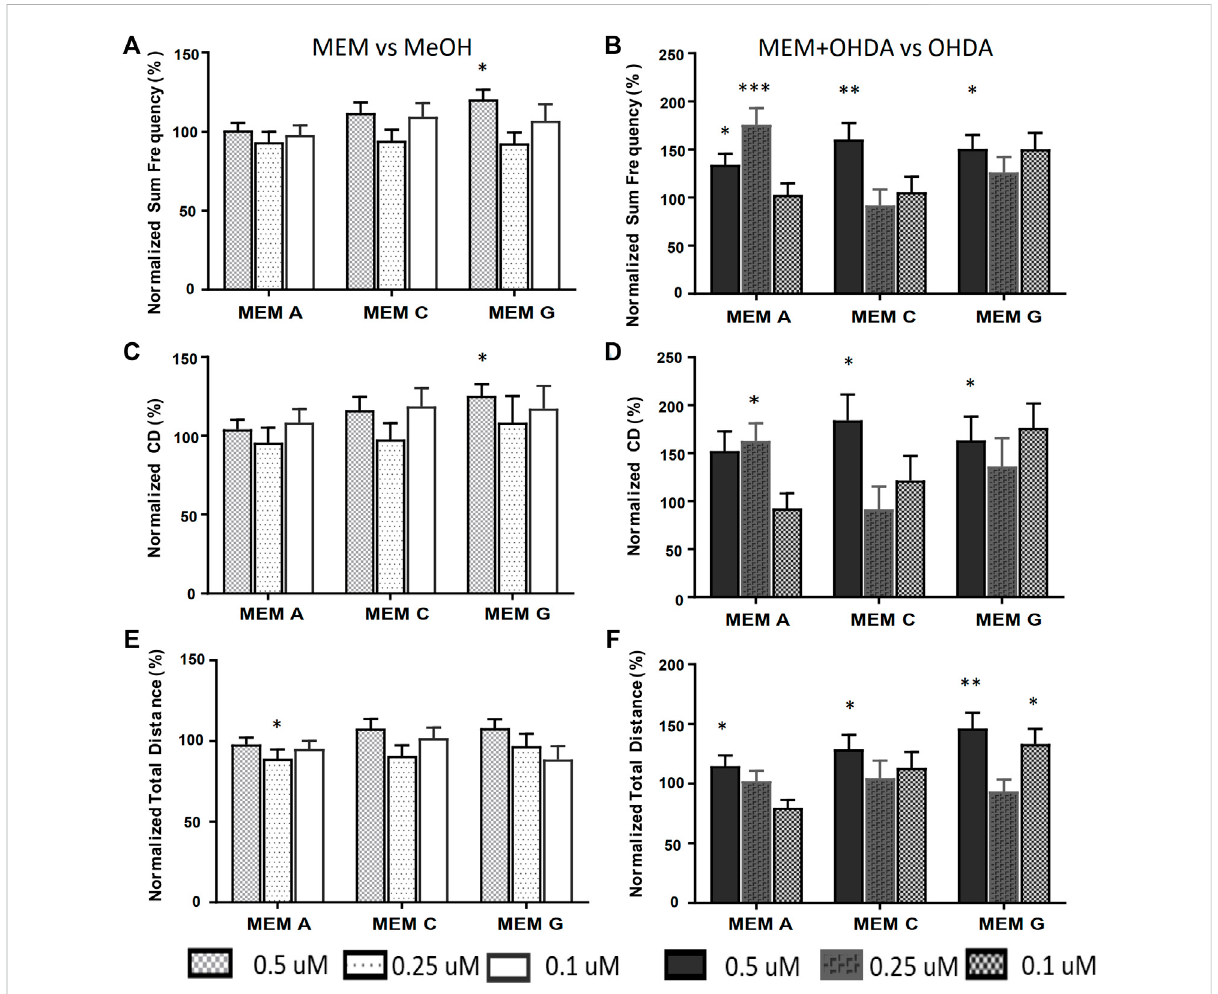
FIGURE 5 Equimolar MEMs alleviate both OHDA mediated Total Frequency and Cumulative Duration de fi cits. Activity metrics of Total Frequency (A,B) , Cumulative Duration (C,D) and Total Distance (E,F) for equimolar MEMs at 500, 250 and 100 nM (166.7, 83.3 and 33.3 nM each ingredient respectively). MEM vs. methanol carrier control (A,C,E) , and MEM+150 µM OHDA vs. 150 µM OHDA (B,D,F) . * p < 0.05, ** p < 0.01, *** p <